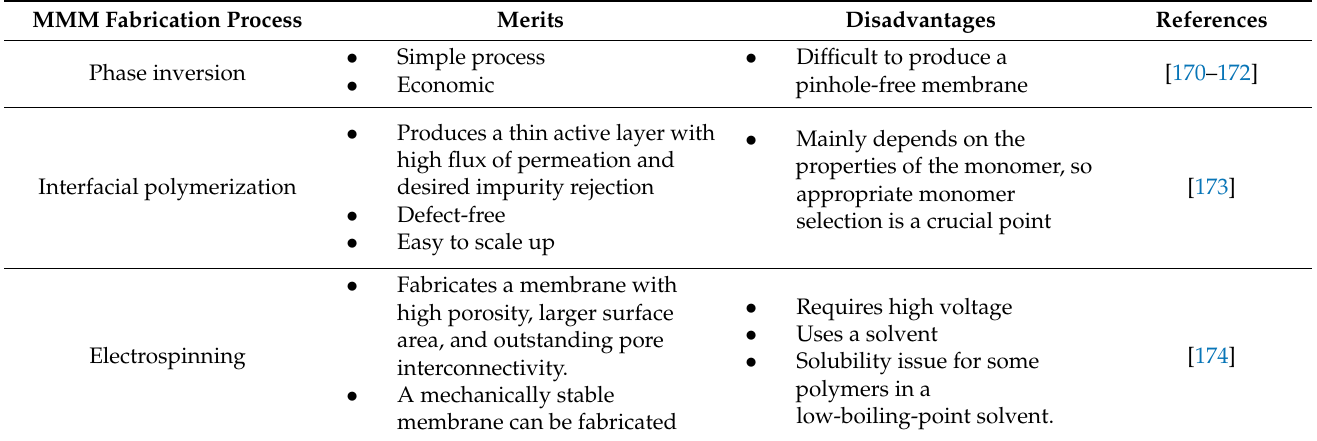
Table 3. Merits and disadvantages of MMM fabrication